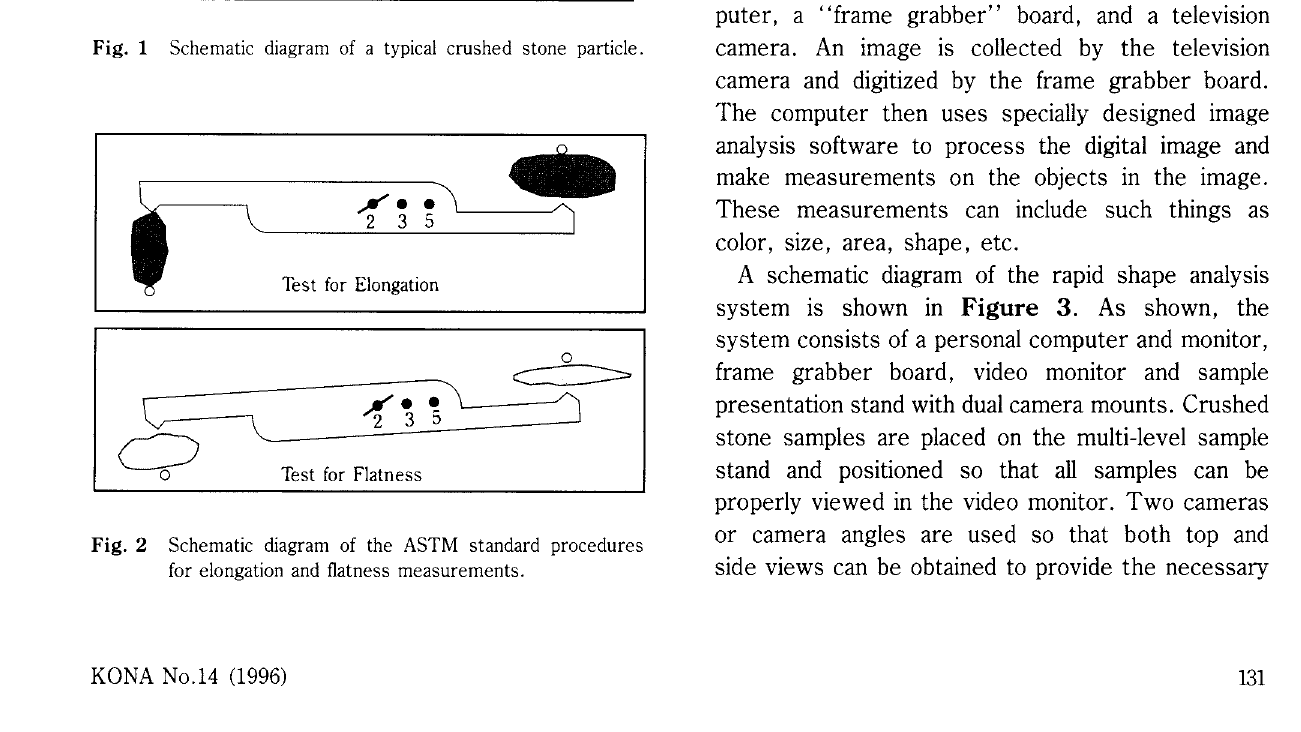
Fig. 1 Schematic diagram of a typical crushed stone particle.